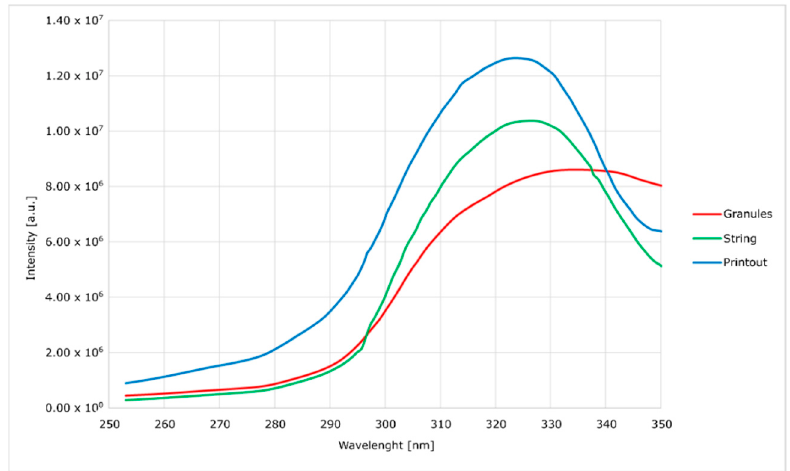
Figure 6. Excitation spectra of nanosilica-modified PC .